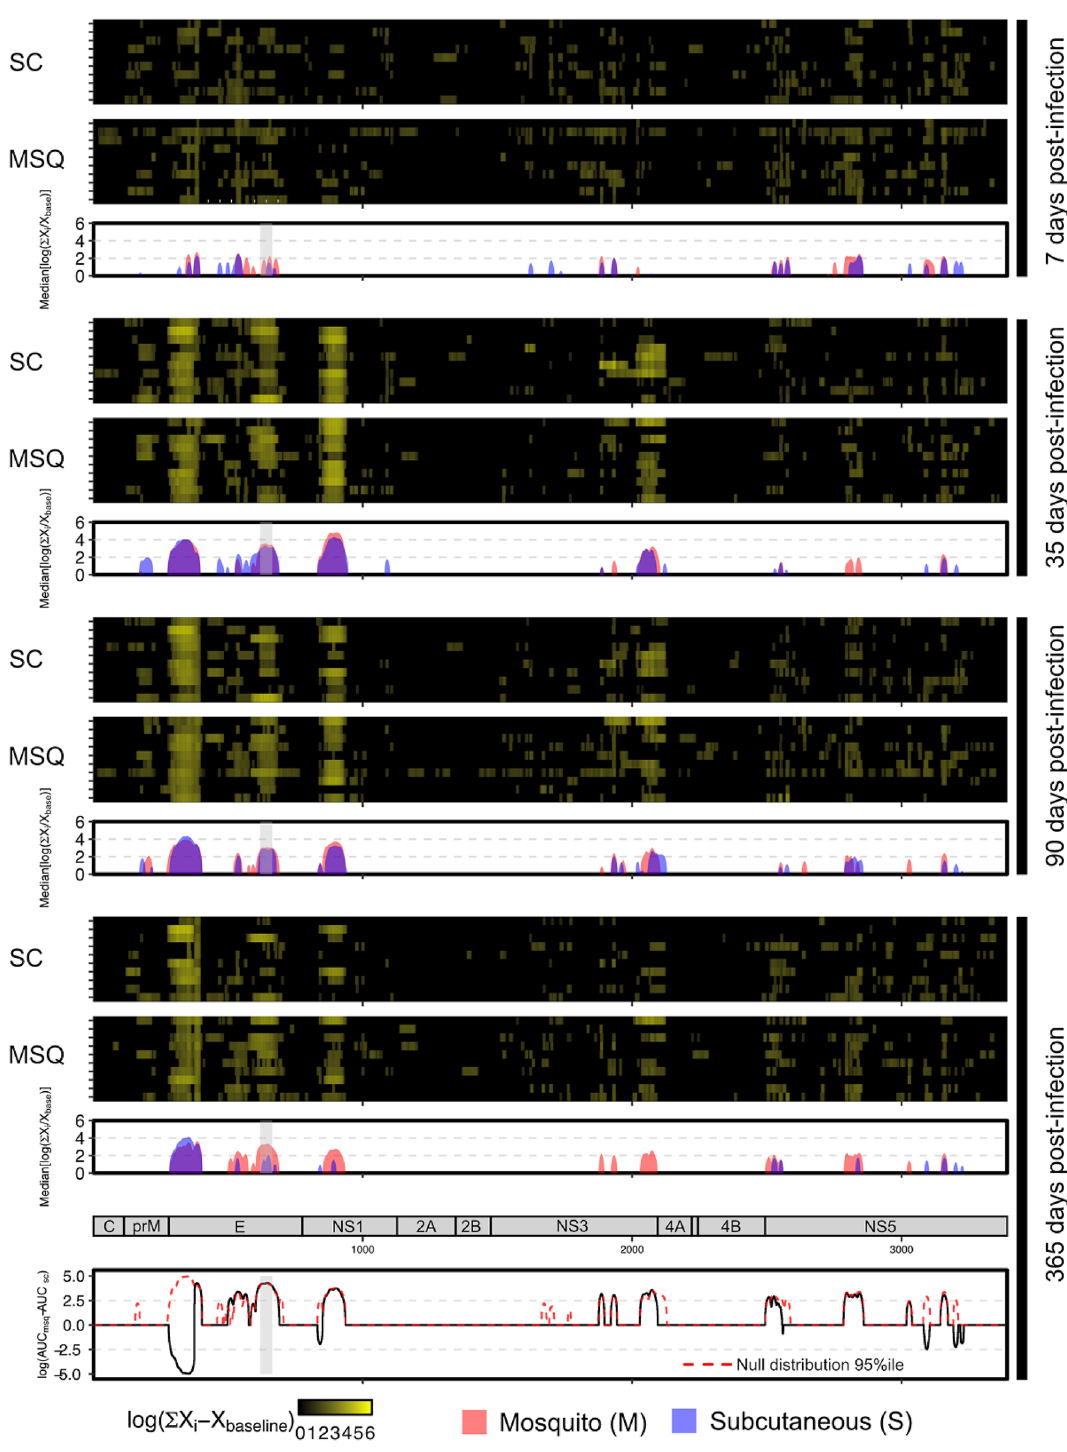
Figure 2. Non-human primates infected by mosquito demonstrated persistent differences in sero-reactivity across the DENV1 proteome. Significantly enriched peptides were aligned to the DENV1 reference proteome and median enrichments computed. The E, NS1, NS3 and NS5 proteins were the most frequently targeted and by 365 days post-infection, while reactivity to E, NS1 and NS3 remained high in subjects infected by mosquito (red), they declined in those infected by subcutaneous injection (blue). Within the E protein, the differential reactivity centered on amino-acid residues 339–384 (grey rectangle), with a statistically significant difference in the AUC. The 95%ile of the null distribution of the AUC difference is shown with a red dotted